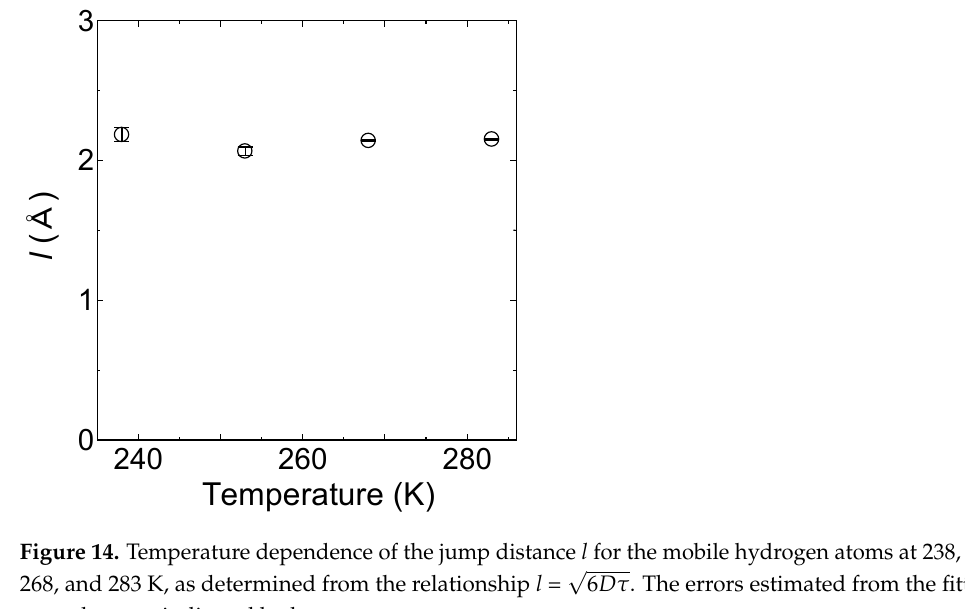
Figure 14. Temperature dependence of the jump distance l for the mobile hydrogen atoms at 238, 253, 268, and 283 K, as determined from the relationship l = √6𝐷𝜏 . The errors estimated from the fitting procedure are indicated by bars.